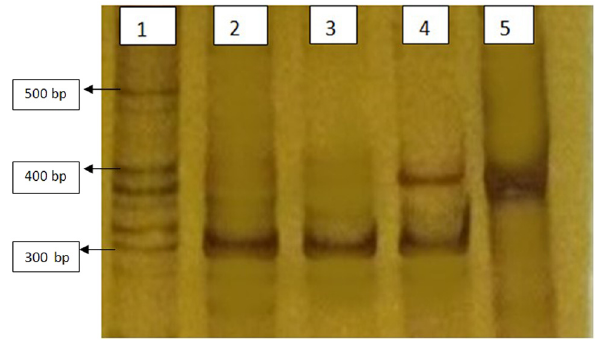
Figure 2: Silver stained polyacrylamide gel electrophoresis showing di ff erent transcripts of BCR – ABL after RT - PCR with e12a2 primer. All lanes are positive for BCR – ABL mutation typical p210 kDa ( e13a2 and/or e14a2 ) transcripts. Lane 1 shows ladder ( molecular weight marker ) of various size fragments. bp ( base pair ) . Lanes 2 and 3 are from chronic phase CML patients expressing 310 bp fragment of e13a2 BCR – ABL. Lane 4 is from a chronic phase CML patient co expressing both e13a2 and e14a2 BCR – ABL. Lane 5 is from a chronic phase CML patient expressing 385 bp fragment of e14a2 BCR – ABL.